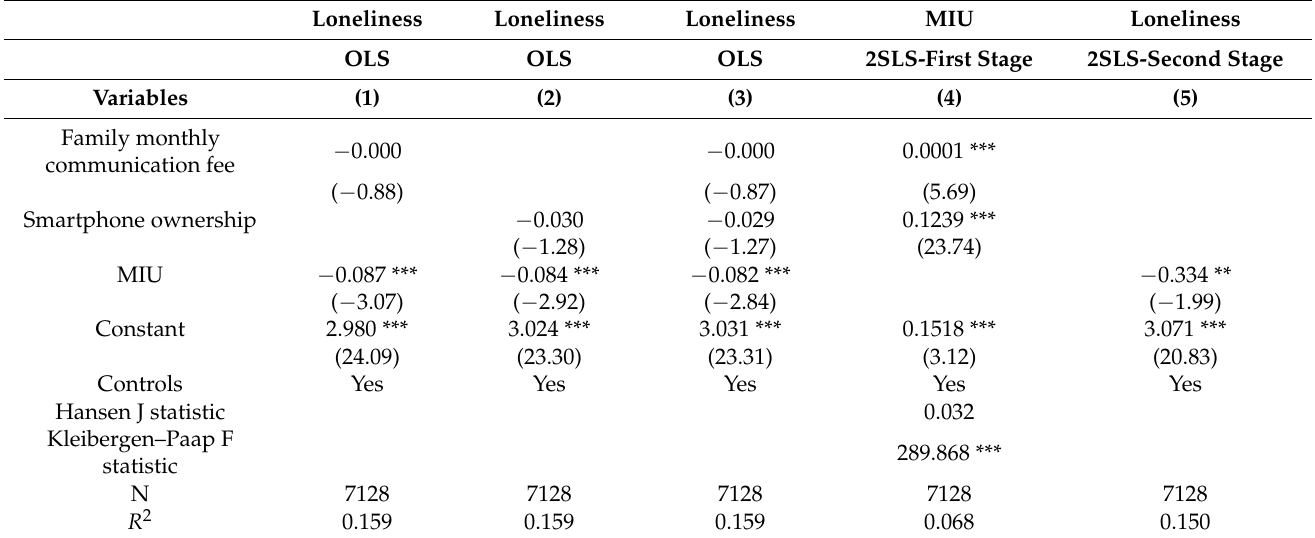
Table 3. Test for the validity of the two instruments and the 2SLS